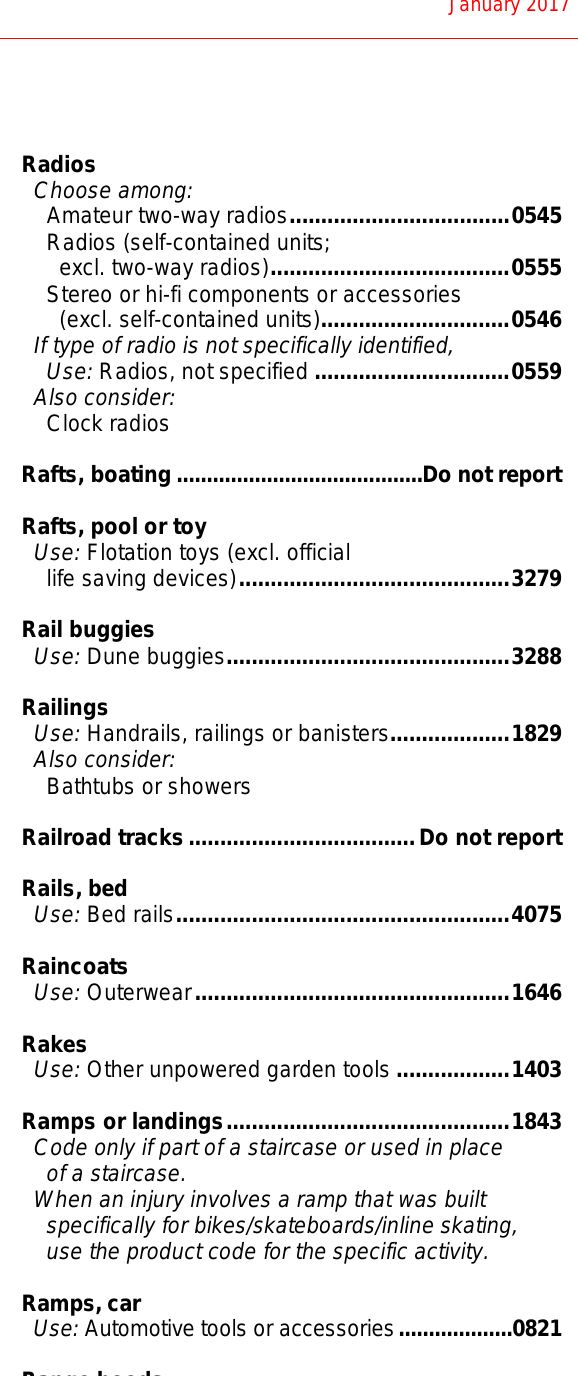
Racquet ball Use: Squash, racquet ball or